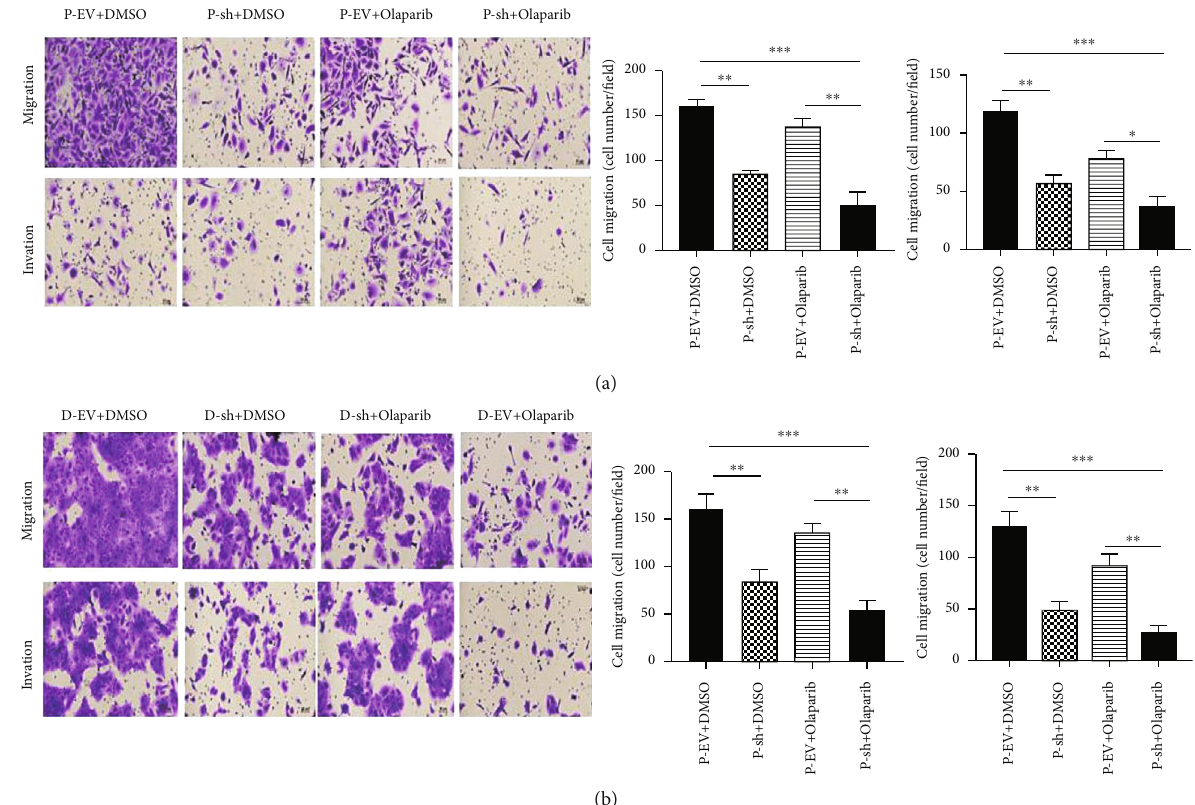
Figure 7: E ff ects of MUS81 silencing combined with Olaparib on the invasion and migration ability of CRPC cells. (a, b) The migration and invasion of D-EV, D-sh, P-EV, and P-sh following 48 hours of either Olaparib or DMSO treatment by Transwell assays. ∗ P < 0 : 05 , ∗∗ P < 0 : 01 , and ∗∗∗ P < 0 : 001 , versus EV-treated